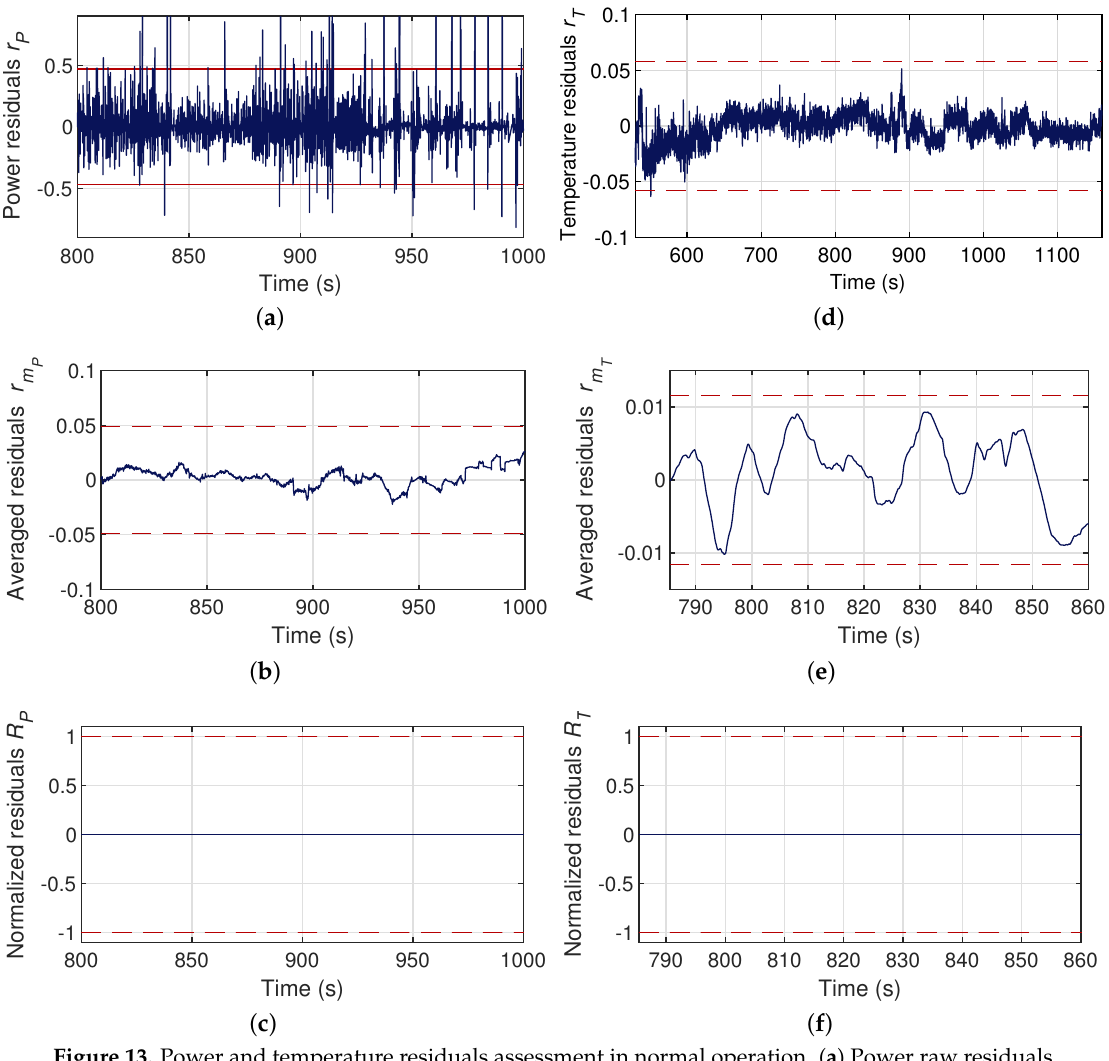
Figure 13. Power and temperature residuals assessment in normal operation. ( a ) Power raw residuals r P . ( b ) Power averaged residuals r m . ( c ) Power normalized residuals R P . ( d ) Temperature raw P residuals r T . ( e ) Temperature averaged residuals r m . ( f ) Temperature normalized residuals R T T